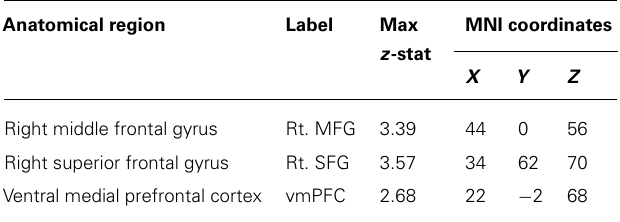
Table 3 | Statistical peaks of cortical regions recruited during the Active > Passive condition atTime 2 > Time 1 contrasting the control group with the training groups (Control >